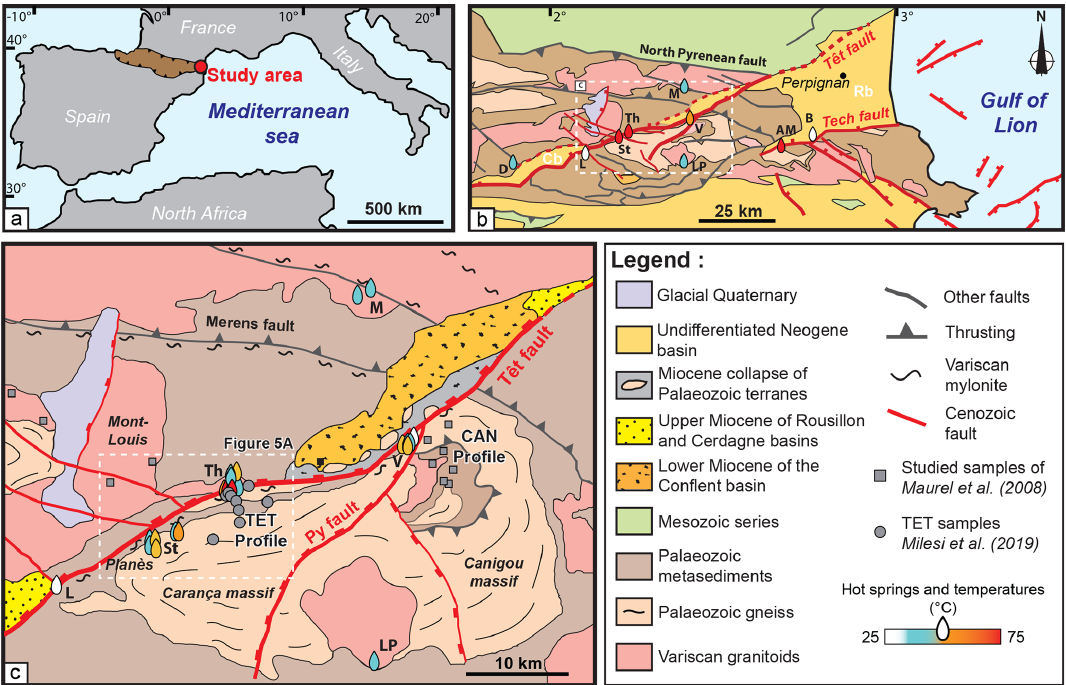
Figure 1. (a) Regional map at the scale of the Mediterranean basin: the outline of the Pyrenees is shown in brown and the study area is indicated with a red dot. (b) Structural map with principal faults and units; hot spring clusters are reported with coloured drops. D: Dorres, L: Llo, St: St Thomas, Th: Thuès-les-bains, V: Vernet-les-bains, LP: La Preste-les-bains, AM: Amélie-les-bains, B: Le Boulou, M: Molitg- les-bains. Roussillon basin: Rb, Cerdagne basin: Cb (modified from Taillefer et al., 2017). (c) Local map with the location of previously published AHe ages and the location of the studied area (dashed rectangle, Fig. 5a). Hot springs are also represented by drops (modified from Maurel et al.,